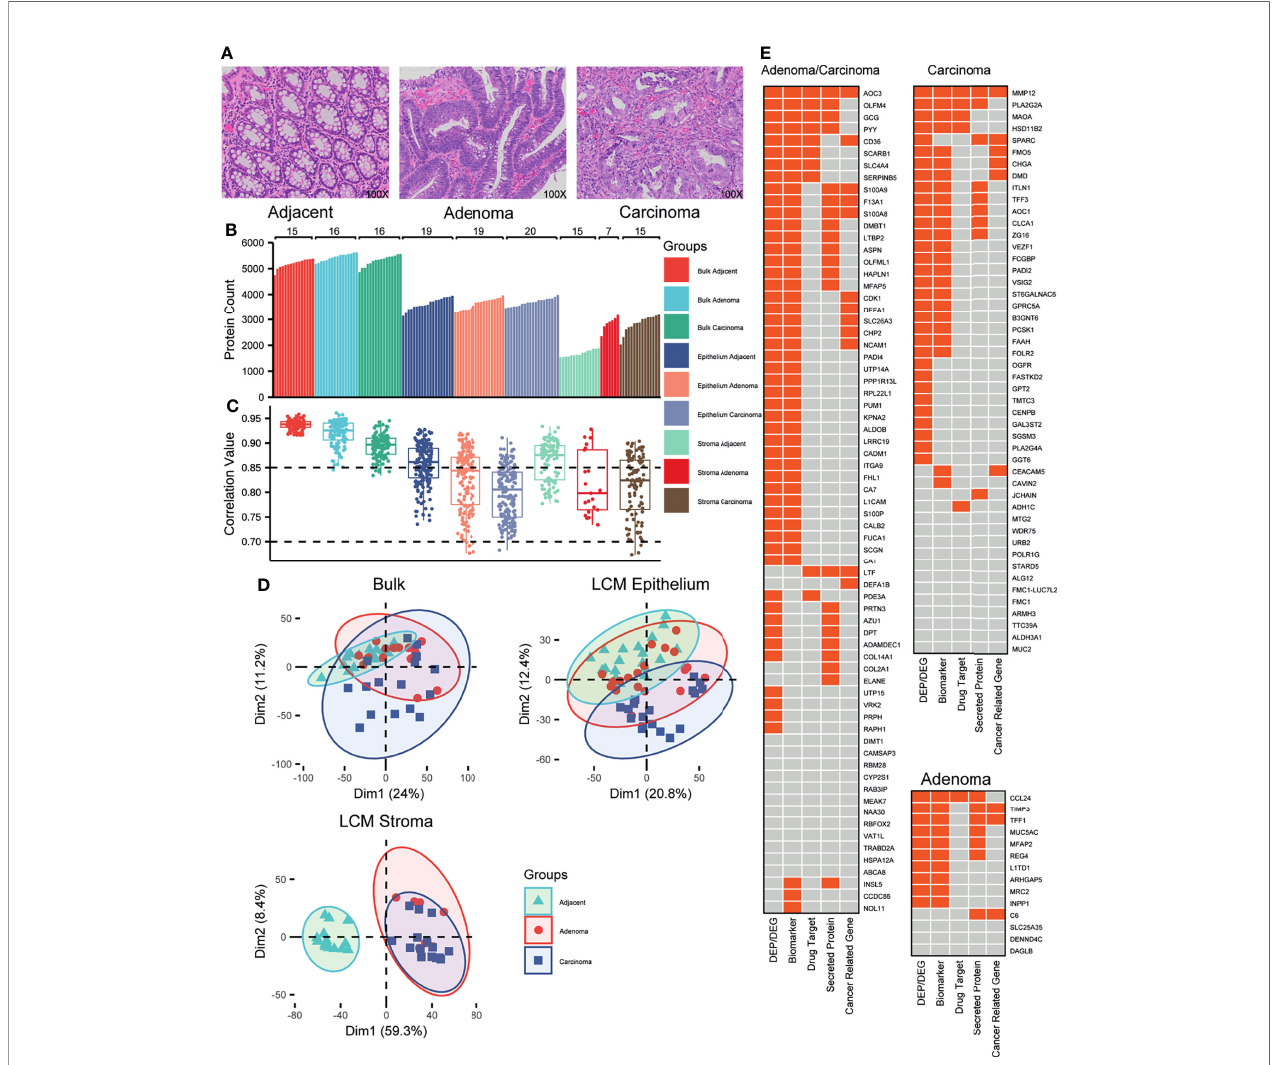
FIGURE 1 | Proteomic overview of the colorectal tissues. (A) Representative images of colorectal tissues, including adjacent, adenoma, and carcinoma. Original magni fi cation, ×100. (B) Distribution of the identi fi ed proteins in individual samples from 22 CRC patients. (C) Distribution of the protein abundance correlations among the samples within a group labeled. (D) PCA plots for the proteomes responsive to adjacent, adenoma, and carcinoma. (E) The biomarker heatmaps that recognize the adjacent from the adenoma and carcinoma (left), from the carcinoma (upper right), and from the adenoma (lower right) identi fi ed using both bulk and LCM samples. The boxes with orange indicate the CRC-related gene expression previously